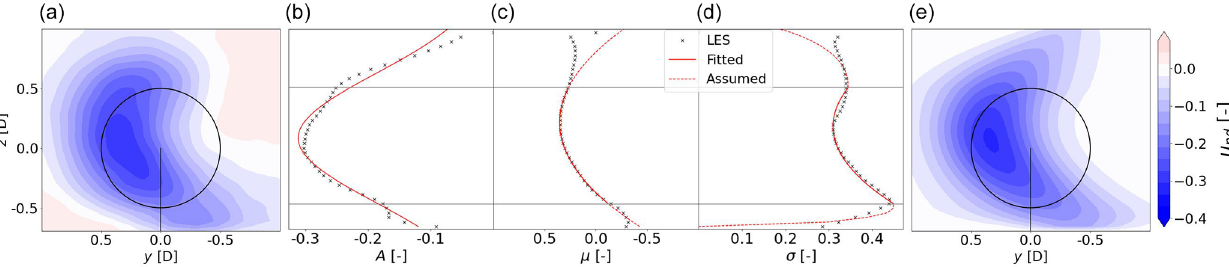
Figure 4. Exemplary figures (BL1, φ =+ 30 ◦ , x = 5D) illustrating the key wake steering parameters. (a) Normalized wake deficit cross- section (contour) of original LES data. (b) The local normalized wake center deficits A , (c) local wake center positions µ , and (d) local wake widths σ . Black crosses indicate LES, solid red lines the relation fitted in according to the multiple 1D Gaussian method (Sect. 3.1) and dashed red lines the assumed continuation in the reversed multiple 1D Gaussian composition method (Sect. 3.4). (e) Cross-section (contour) of the normalized wake deficit after applying the reversed multiple 1D Gaussian composition method.